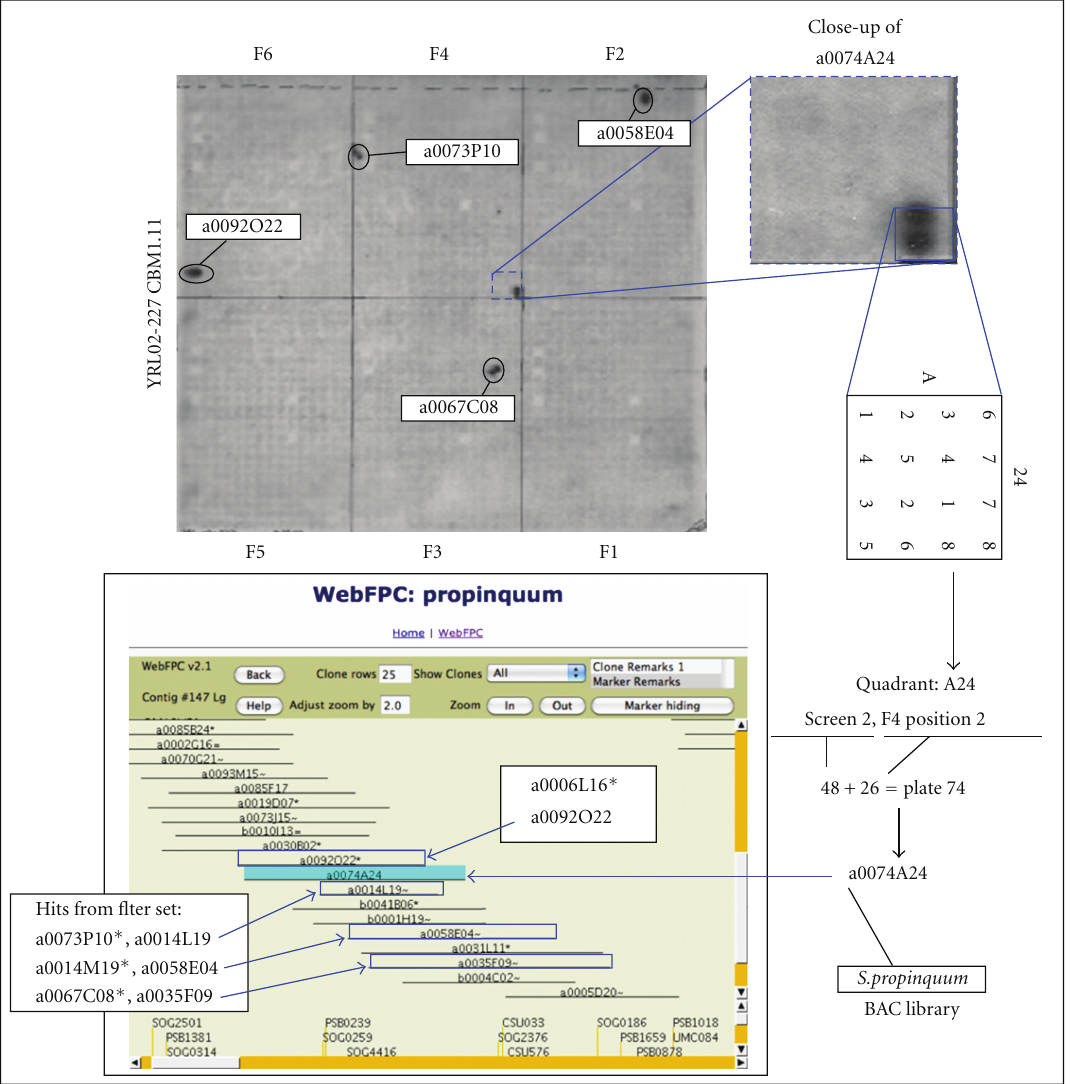
Figure 2: BAC filter hybridization, scoring of hits, and location in fingerprint contig (FPC) map for maize CBM1.11 (umc161). A representative filter-screen hybridization (Table 2, step 2) and the autoradiograph from one of the two filters are shown (top). A total of 5 positive signals are seen (circled or boxed), and the scoring scheme for one of them (a0074A24) is illustrated at the right. The autoradiograph is labeled to show the location of the 384-well plate fields 1–6 (F1–6), and the geometry duplicate spotting of the eight individual plates per field is indicated at the right for quadrant A24. A close-up of one hit (position 2, field 3) is shown with the resulting decoded BAC ID of plate 74 position A-24 (a0074A24). This BAC, along with four other contiguous (arrows) BACs, is indicated within contig number 113 of the Sorghum propinquum FPC map (screen capture bottom left). Four additional BACs (asterisks) were detected, but not found to belong to a